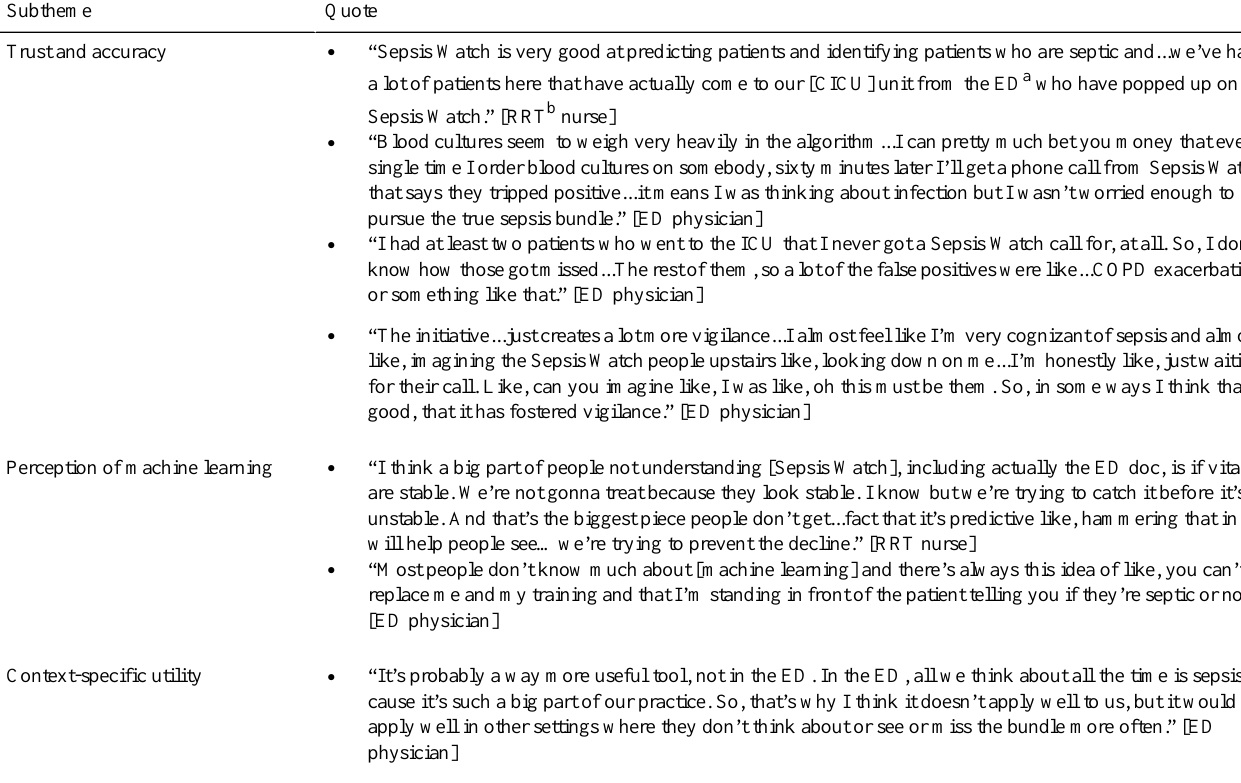
Table 4. Representative quotations on perceived utility and